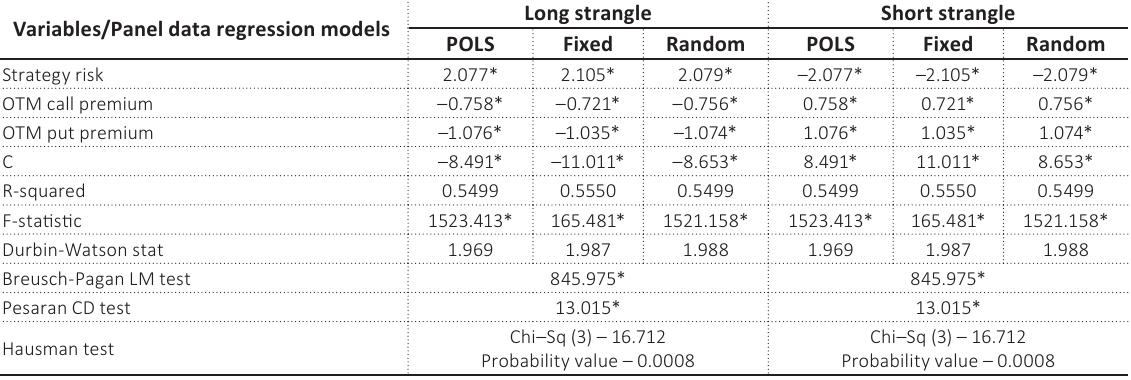
Table 5. Panel regression analysis for long strangle and short strangle strategies Variables/Panel data regression models